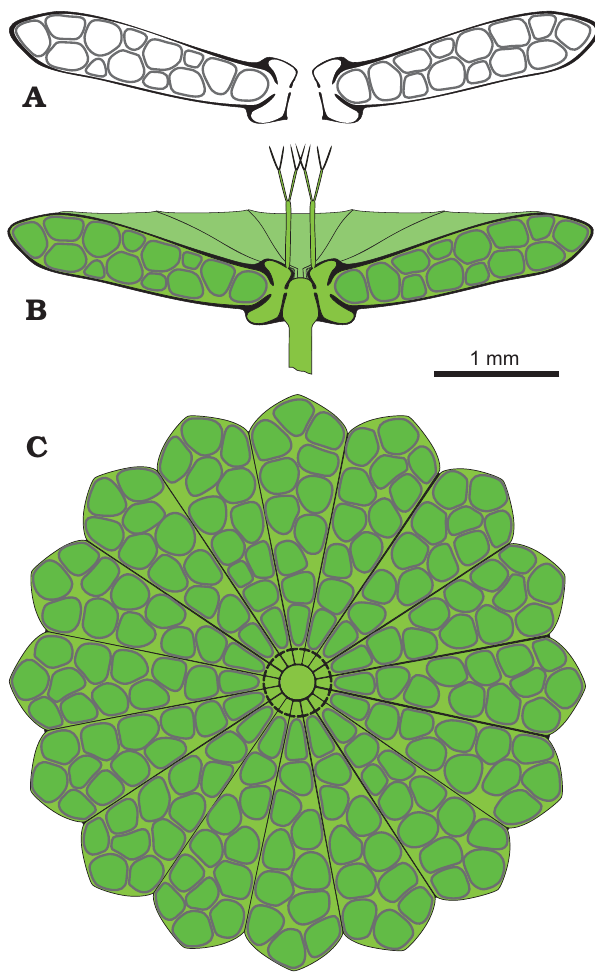
Fig. 9. Reconstruction of polyphysacean alga Acetabularia moldavica sp. nov. A . Mineralized fertile cap in axial section. B . Soft parts (green) and calcareous skeleton (black and dark gray) in axial view. C . Fertile cap in upper